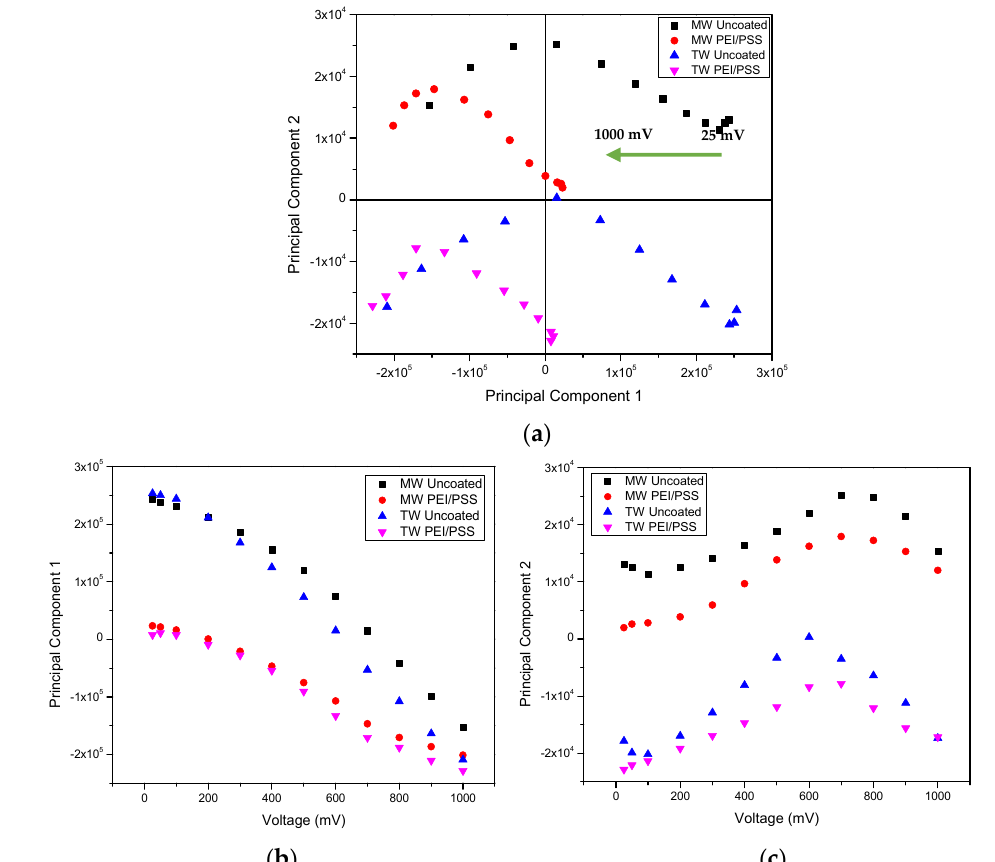
Figure 8. PCA plots of all IDE (uncoated and with (PEI/PSS) 5 film) in both types of water used: ( a ) PC1 vs. PC2, ( b ) PC1 vs. voltage applied, ( c ) PC2 vs. voltage applied. The green arrow illustrates the ordered sequence of voltage values, from 25 mV up to 1000 mV.